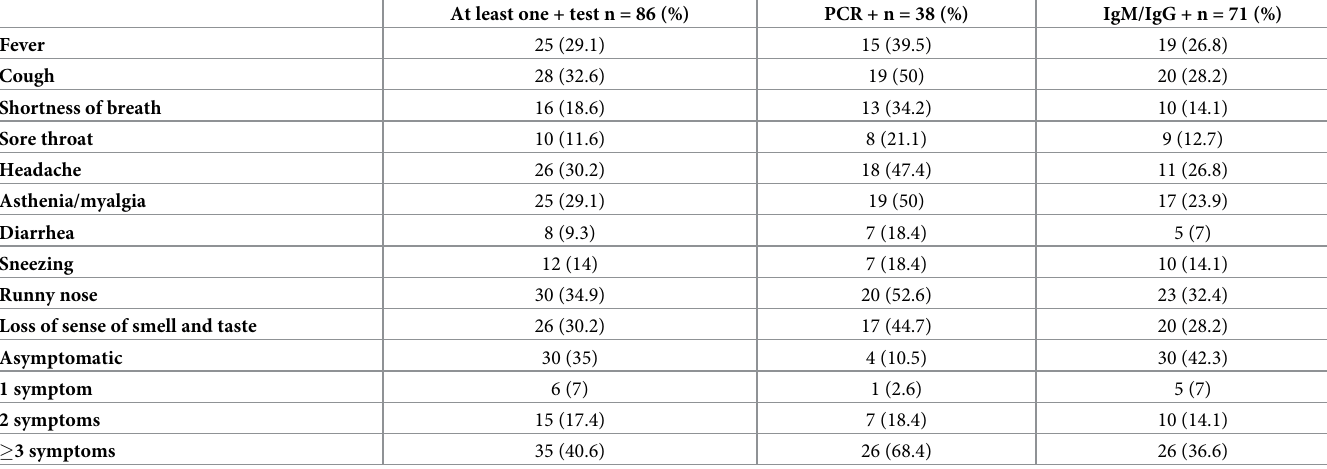
Table 4. Symptoms suggestive of SARS-CoV-2 infection by test type and result among SARS-CoV-2-positive pregnant women.